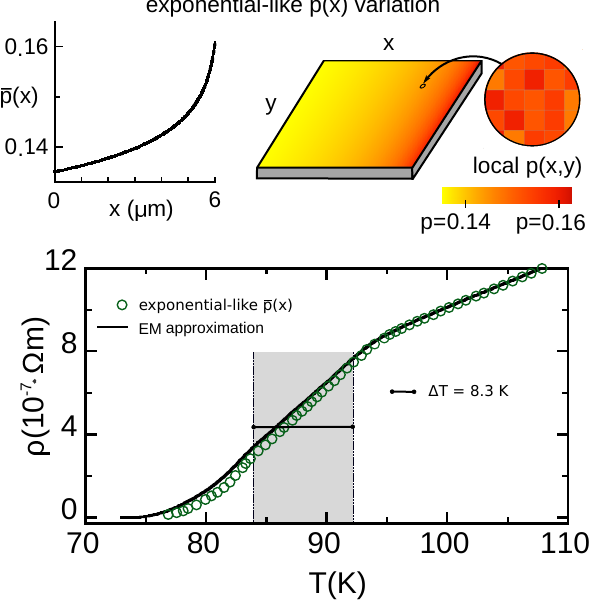
Figure 4. In the upper row, we illustrate a YBCO film patterned following the exponential-like variation of nominal doping p ( x ) studied by us in Section 6 (see Equations (20) to (22)). We also illustrate doping across the film as a 2D color map, taking into account that the local doping level p ( x , y ) (zoom in the picture) results from accumulating the exponential-like p ( x ) and the random Gaussian disorder at smaller length scales of about (30 nm) 2 (see main text for details). In the lower row, we plot the resistivity vs. temperature ρ ( T ) that we obtain for such film (data points for finite-element computations, continuous line for the analytical EM approximation, adapted in this work to this p ( x ) case, see Equation